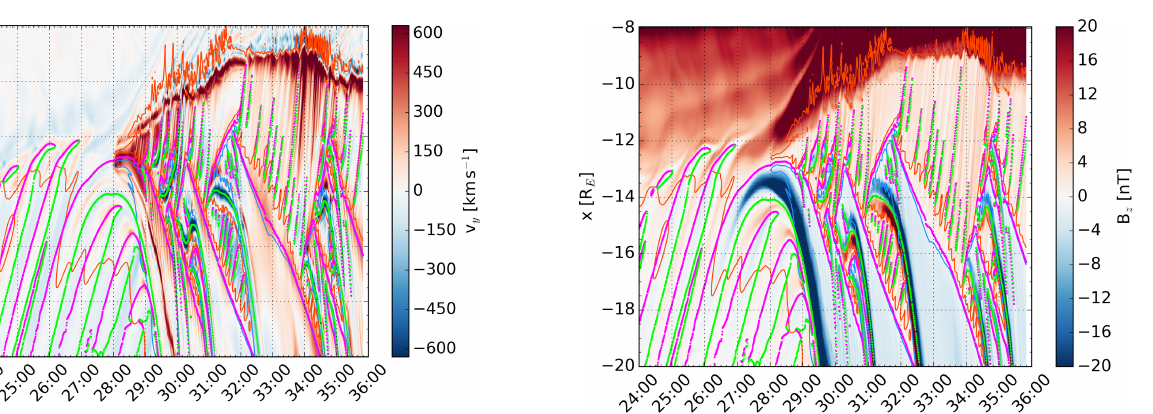
Figure 6. The color shows the z component of the magnetic field as a function of x and time in minutes after the beginning of the simulation (MM:SS). The color scale has been saturated to better show plasma sheet structures that are weaker than the dipole field. Magenta and green dots show the locations of the X and O points, respectively. The ± 400kms − 1 contours are indicated with the or- ange and blue